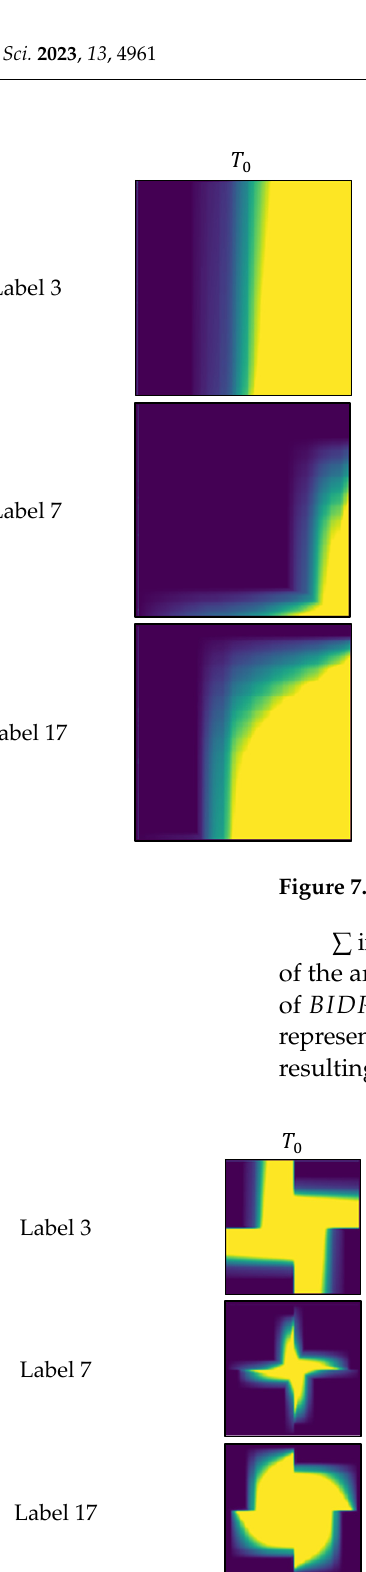
Figure 8. 𝐵𝐼𝐷𝑃 (cid:3006)(cid:2870) examples of 2nd enhanced 𝐵𝐼𝐷𝑃 (cid:3006)(cid:2869) .